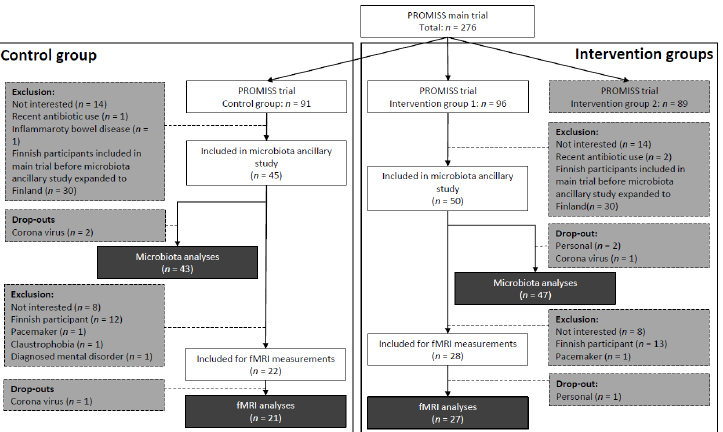
Figure 1. Flowchart for inclusion of participants in the microbiota ancillary study and fMRI measurements of the PROMISS trial. Darkest grey is final number of included participants per group, per substudy. Grey is the number of exclusions. fMRI: functional magnetic resonance imaging; PROMISS: Prevention Of Malnutrition In Senior Subjects in the EU.